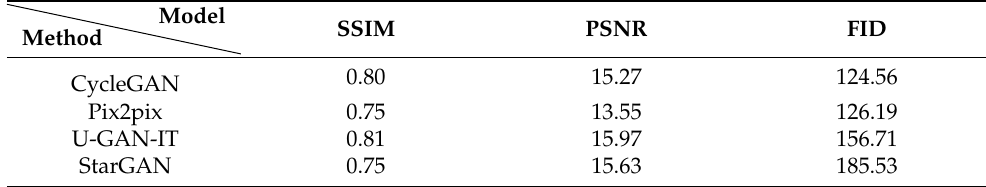
Table 2. Quantitative results of four